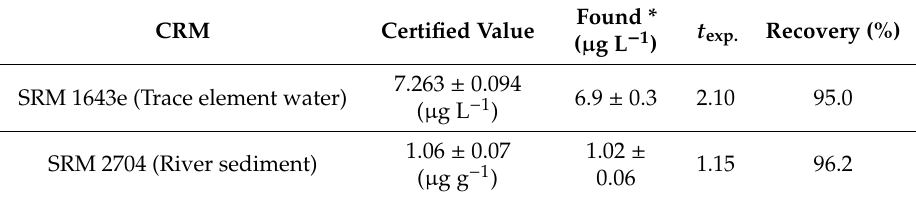
Table 4. Analytical results of thallium determination in certified reference